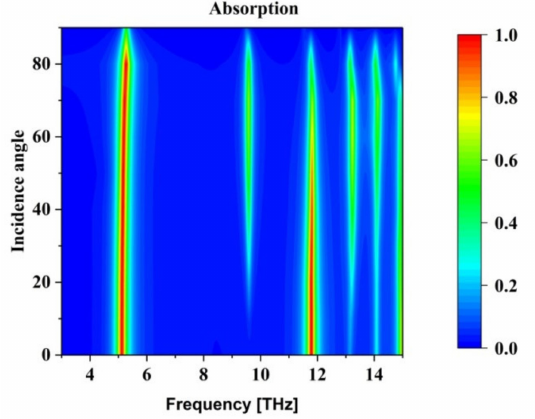
Figure 7. Absorption plot for various incident angles and different frequency.